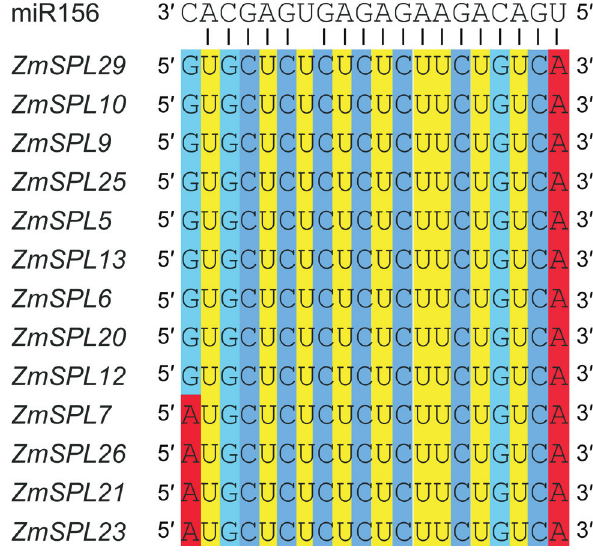
Figure 6 - Sequence alignments of maize miR156 with their complemen- tary sequence in the coding sequences and 3’ UTRs of ZmSPLs